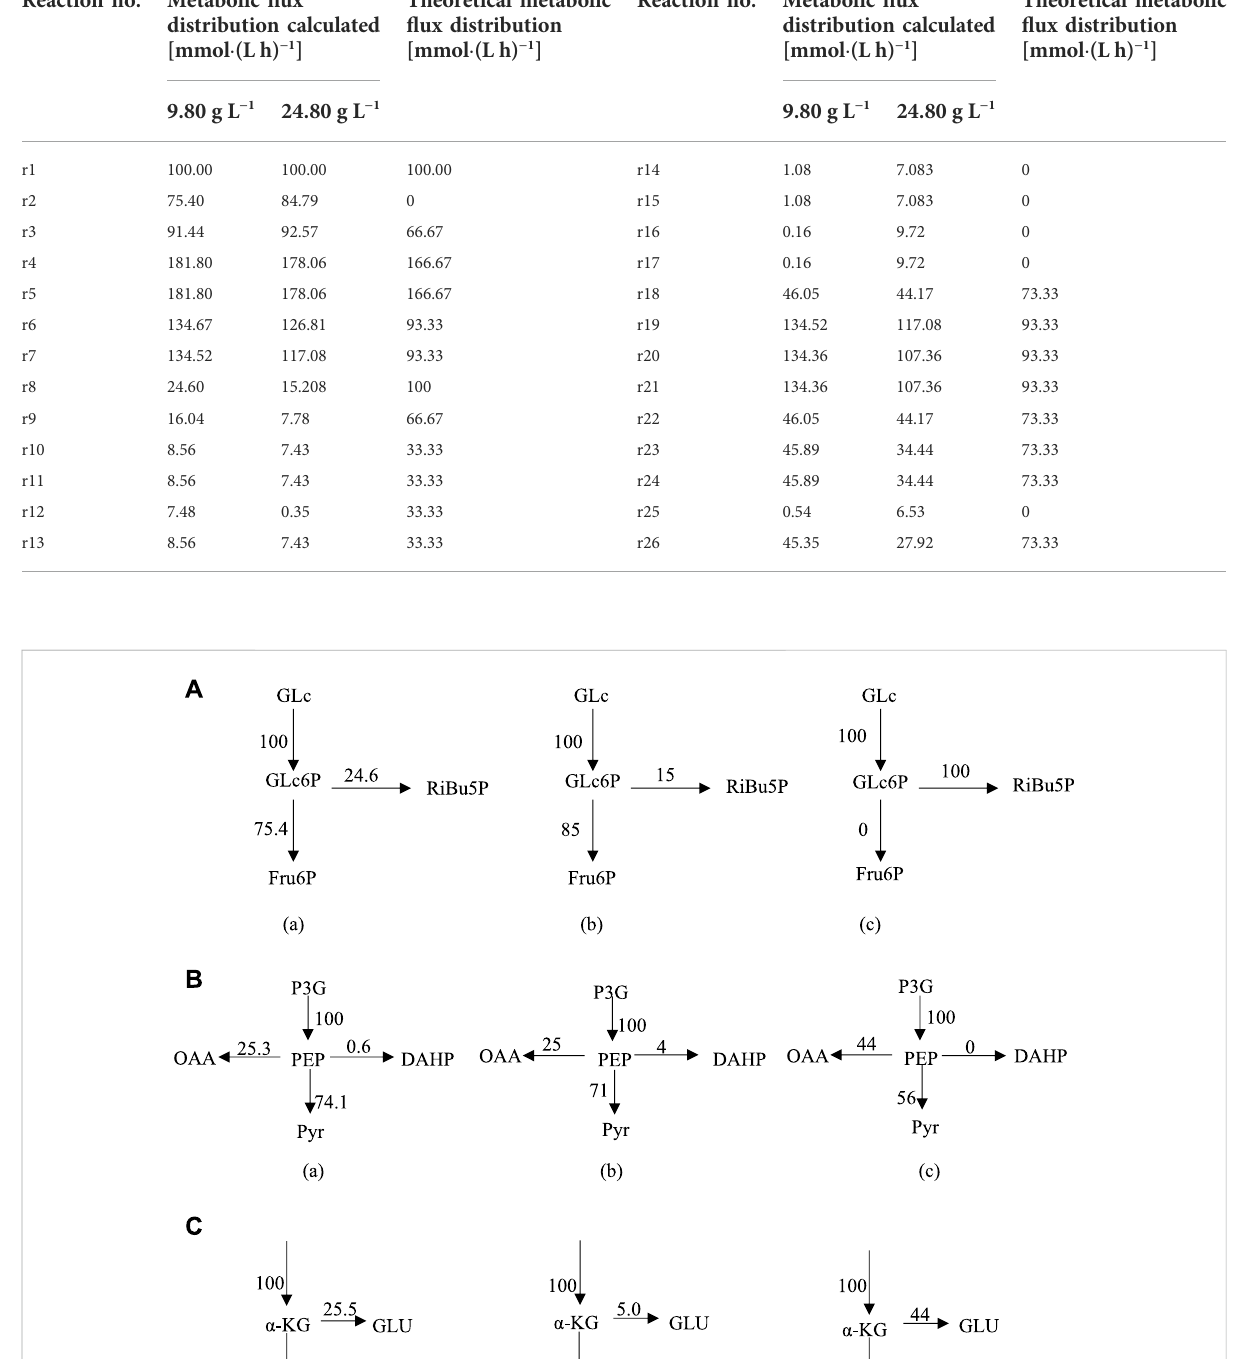
TABLE 1 Metabolic fl ow distribution of Thr biosynthesis network. Reaction no.